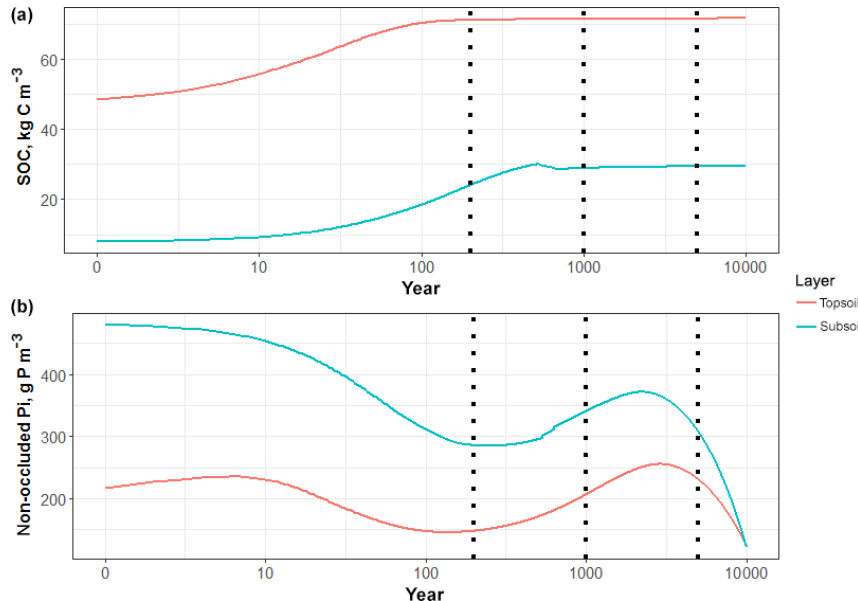
Figure 2. Simulated dynamics of (a) SOC and (b) non-occluded inorganic P contents in topsoil (30cm) and subsoil (30–100cm) for 10000 years. The three vertical dashed lines represent 200, 1000 and 5000